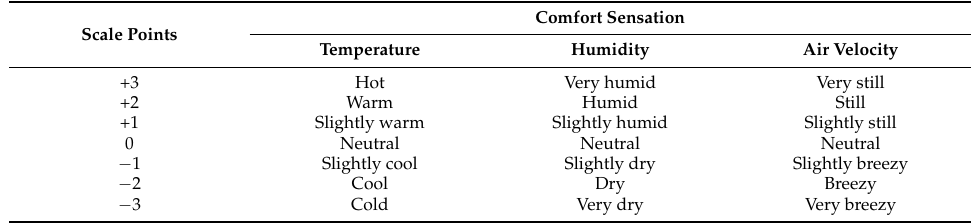
Table 2. The scale of thermal, humidity and air